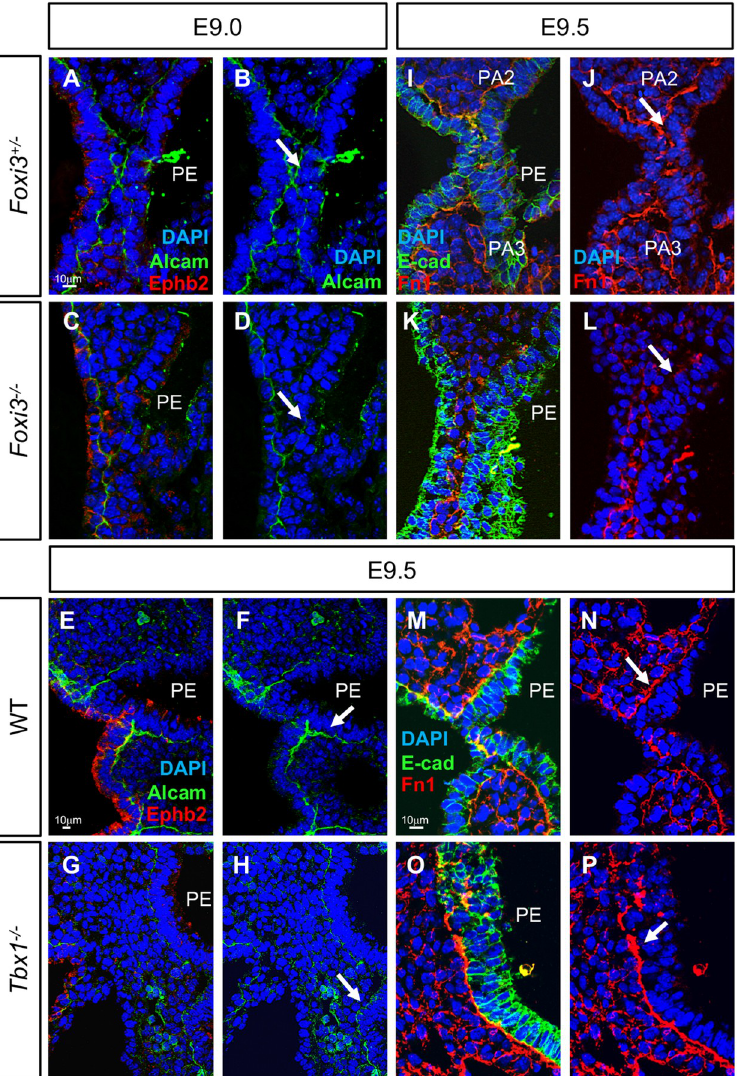
Fig 8. Alcam and Fibronectin expression is reduced in epithelial cells within the PA at E9.5 in Foxi3 -/- , but not in Tbx1 -/- embryos. (A-H) DAPI (blue), Alcam (green) and Ephrin b2 (red) antibodies were used to examine coronal sections in embryos at E9.0. Alcam localizes to the basal side of epithelium and Ephrin b2 localizes to the apical side. Sections from Foxi3 +/- control embryos are shown with all three fluorescence color channels (A) and only DAPI and Alcam (B). Sections from Foxi3 -/- embryos are shown with all three channels (C) and only DAPI and Alcam (D). Sections from WT littermates of Tbx1 -/- embryos are shown with all three channels (E) and only DAPI and Alcam (F). Tbx1 -/- embryos are shown with all three channels (G) and only DAPI and Alcam (H). White arrows indicate where Alcam expression is reduced in Foxi3 -/- mutant embryos, but is present in Tbx1 -/- embryos in comparison to control embryos. (I-P); DAPI (blue), E-cadherin (E-cad, green) and Fibronectin (Fn1, red) antibodies mark epithelial cells and the intracellular matrix on coronal sections at E9.5. (I-J) Sections from Foxi3 +/- control embryos shown with all three fluorescent channels (I) and only the red and blue channels (J). (K-L) Sections from Foxi3 -/- embryos showing all three channels (K) and only the red and blue channels (L). White arrows indicate where expression is spotty and inconsistent in Foxi3 -/- mutants. (M-P) Sections from WT (M-N) and Tbx1 -/- embryos (O-P) showing all three channels (M and O) and only the red and blue channels (N and P). White arrow in N and P indicates where Fibronectin expression is increased in Tbx1 -/- mutants. n = 3 for each genotype in each